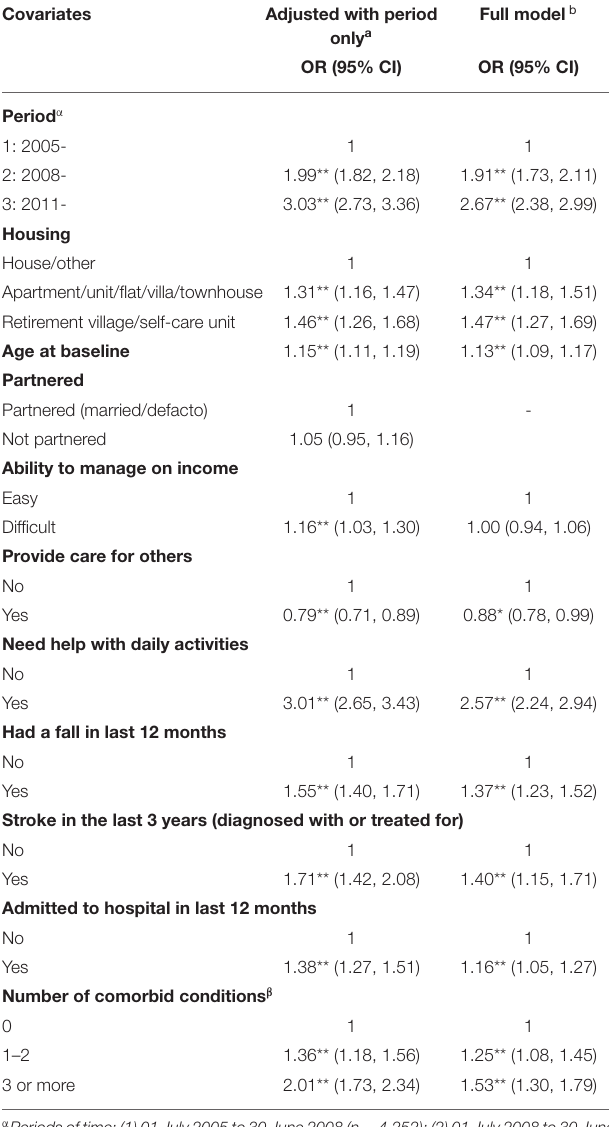
TABLE 5 | Effect of housing and other factors on having an aged care assessment over time among older Australian women. Covariates Adjusted with period only